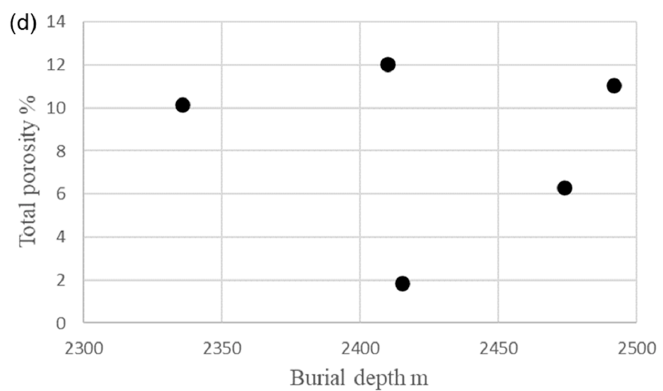
Figure 6. Relationship between porosity and permeability in studied samples. ( a ) Relationship between total porosity and continuous porosity of the studied samples. ( b ) The crossplot of total porosity versus permeability for the studied samples. ( c ) The relationship between continuous porosity and permeability of the studied samples. ( d ) The relationship between total porosity and burial depth of the studied samples.